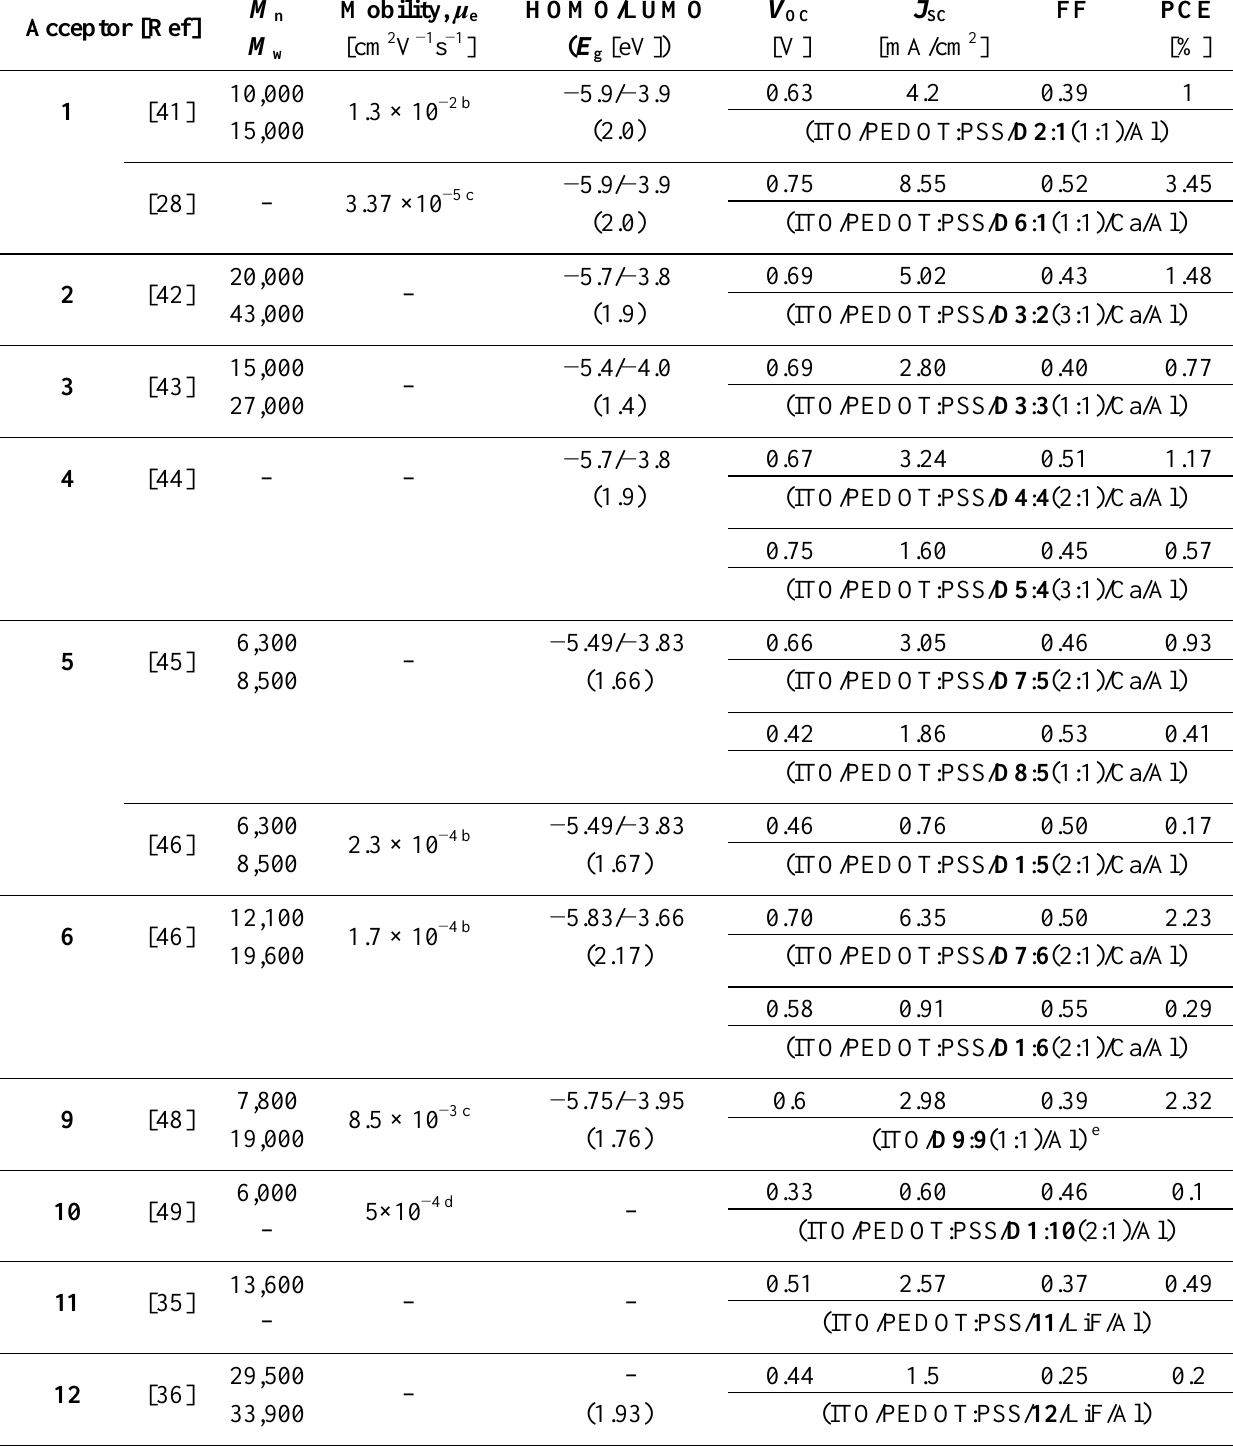
Table 1. Perylene diimide (PDI)-based polymer acceptors a